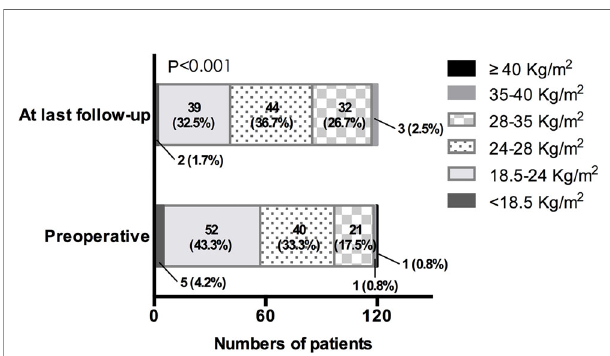
FIGURE 2 | BMI distribution preoperatively and at last follow-up. BMI of <18.5 kg/m 2 for low body weight, BMI of 18.5 – 24.0 kg/m 2 for normal body weight, BMI of 24.0 – 28.0 kg/m 2 for overweight, BMI of 28.0 – 35.0 kg/m 2 for Class I obesity, BMI of 35.0 – 40.0 kg/m 2 for Class II obesity, BMI of ≥ 40.0 kg/ m 2 for Class III obesity.